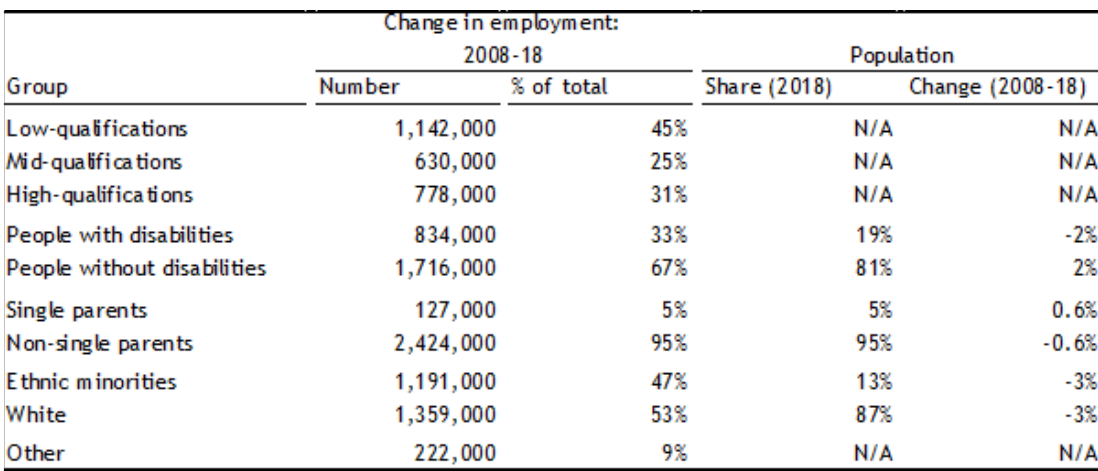
Table 1: Contributions to increase in the number of people in employment, 16-64 year